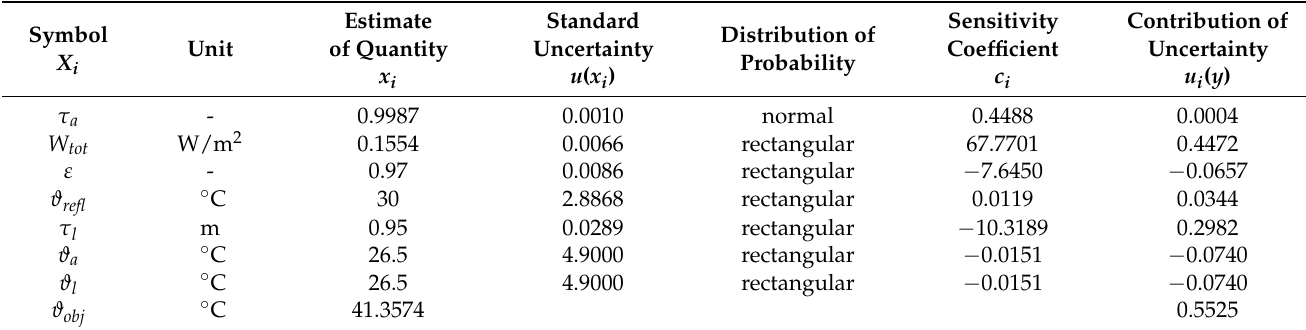
Table 3. Major uncertainty budget determined for the quantity ϑ obj . Change in the lack of sharpness through the change of α (series